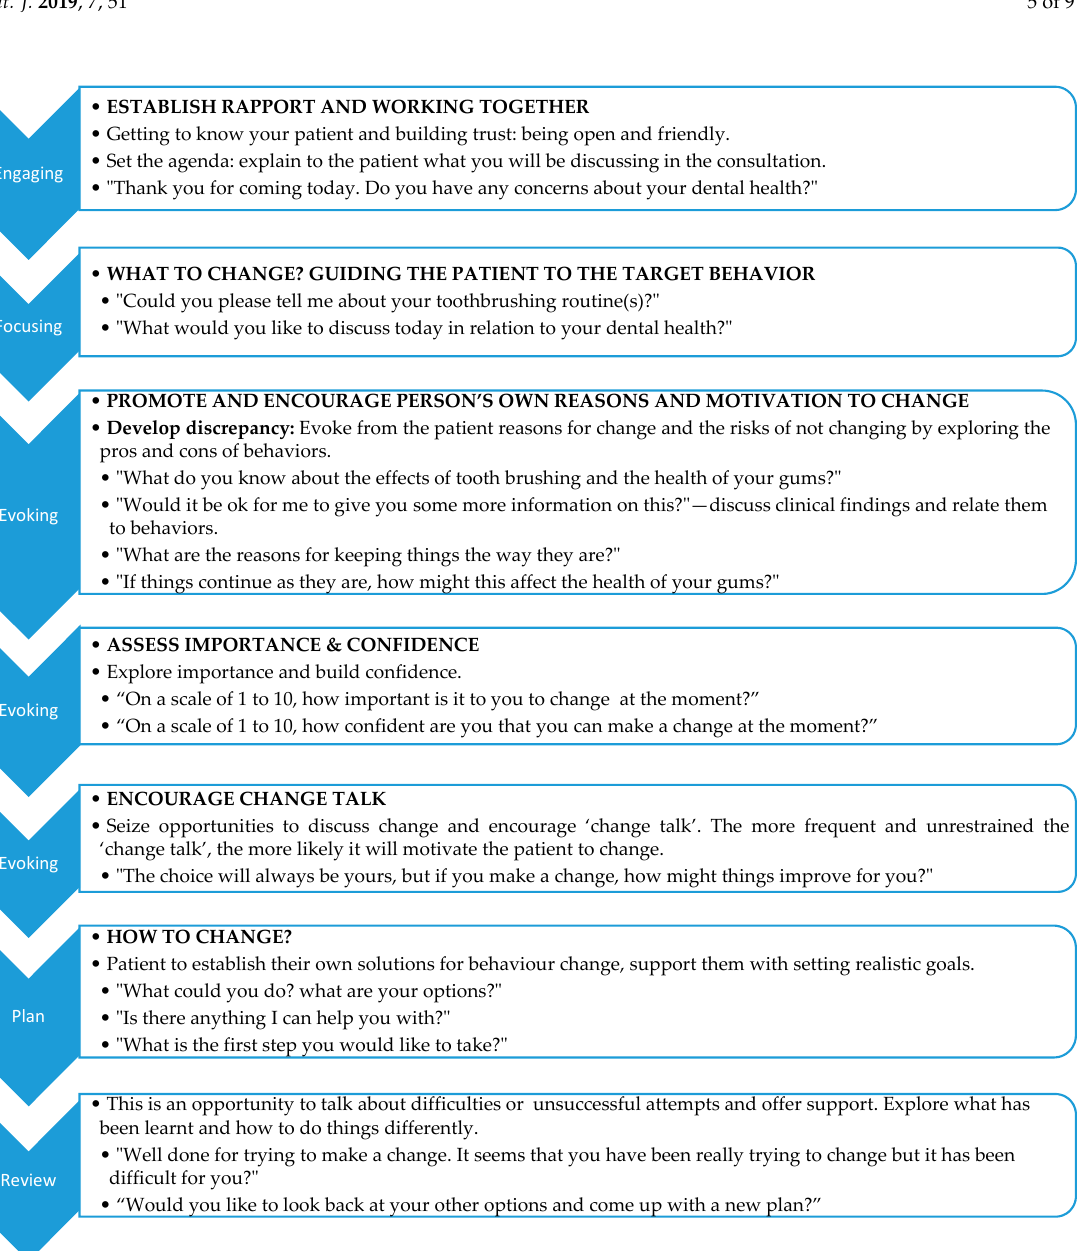
Figure 1. Steps in Motivational Interviewing—going back and forth in steps according to individual patients’ needs.